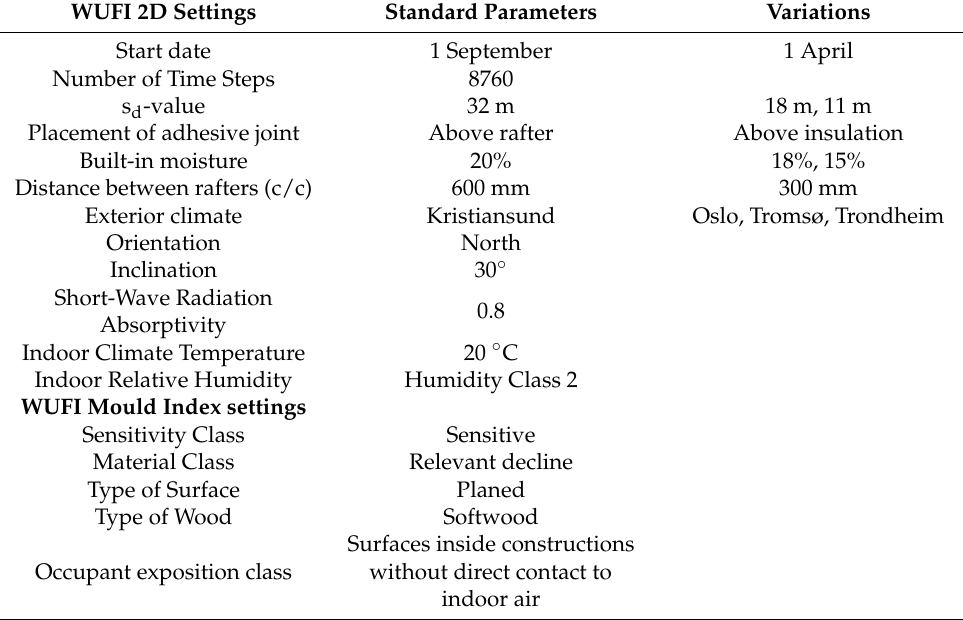
Table 3. Input Parameters for the Simulations in WUFI 2D and WUFI Mould Index VTT.